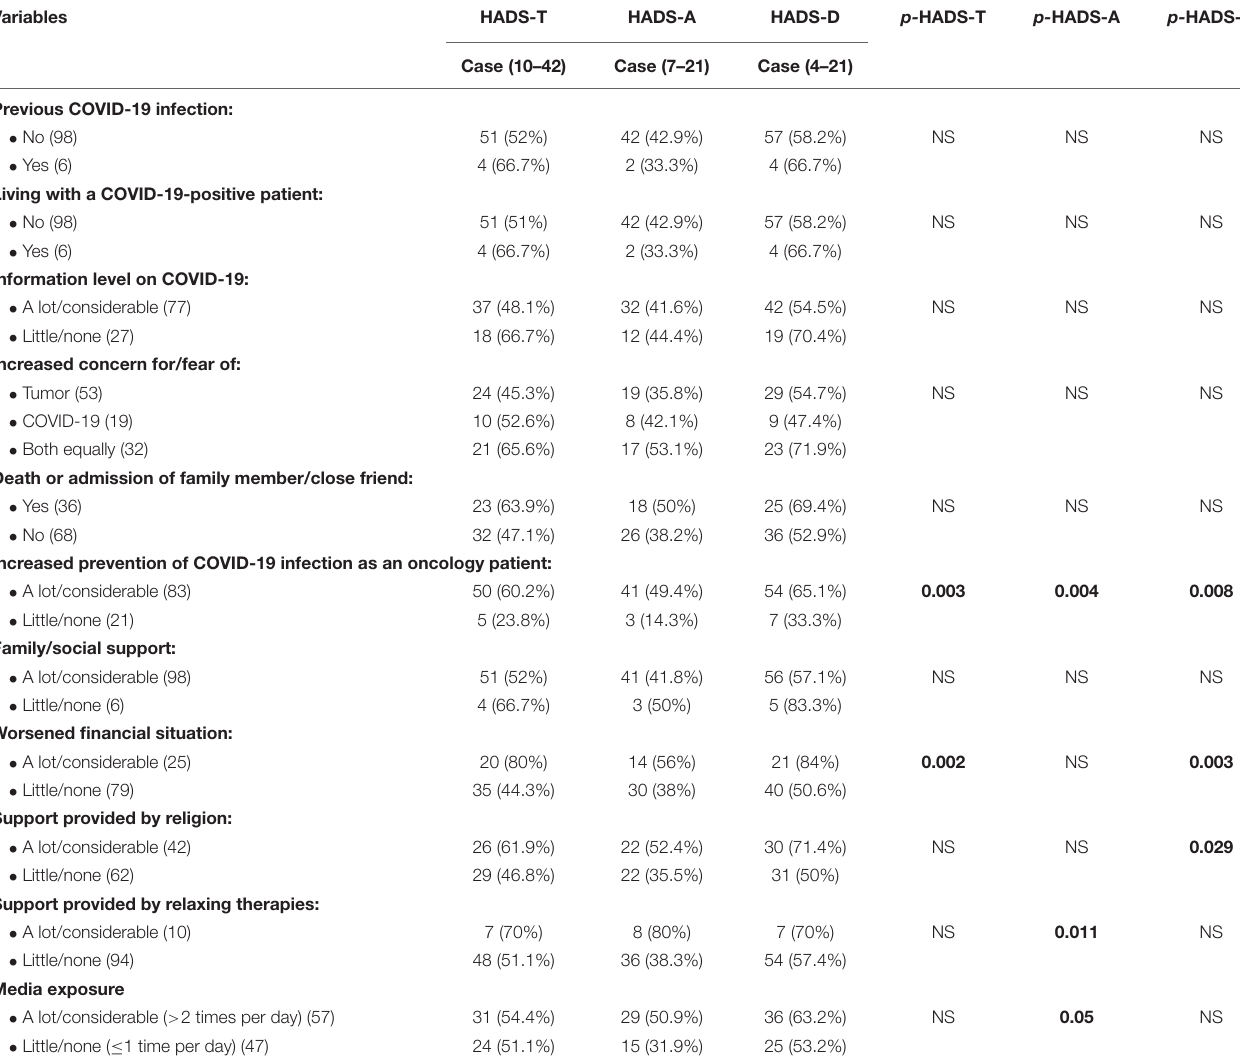
TABLE 4 | Variables related to exposure to COVID-19, and the existence of emotional distress, anxiety, and depression (HADS scale). Variables HADS-T HADS-A HADS-D p- HADS-T p-